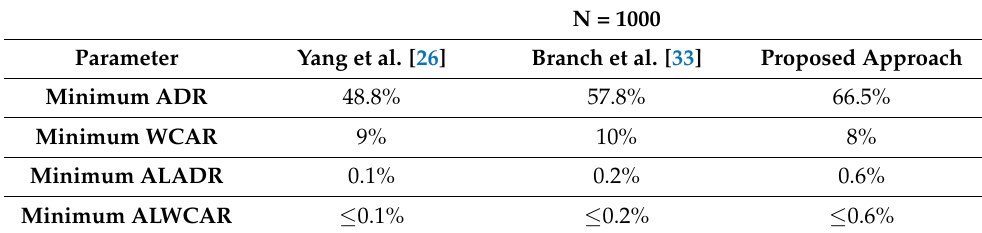
Table 4. Comparative detection ratio analysis at network